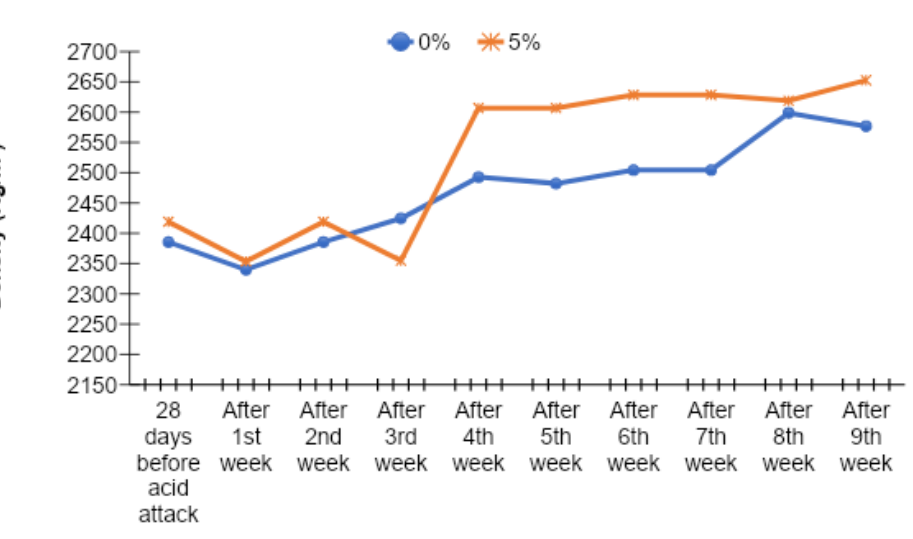
Figure 19. Comparison of density versus time curves for 0% (control) and 5% MK contents.